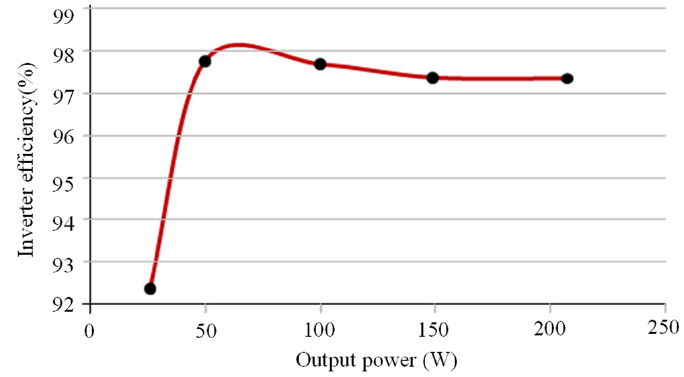
Figure 15. Efficiency versus output power.